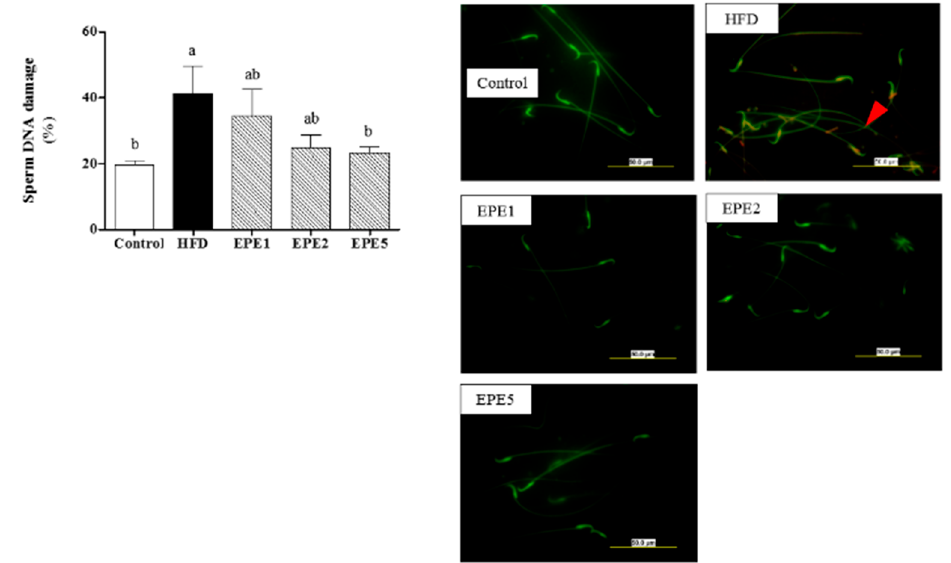
Figure 12. Effects of Echinacea purpurea ethanol extract in sperm DNA damage in HFD-induced obese rats after 5 weeks. Data are shown as the mean ± S.E.M. (n = 5). The values with different superscript letters (a,b) are significantly different ( p < 0.05), as determined via one-way ANOVA, and were analyzed by Duncan’s multiple range test.